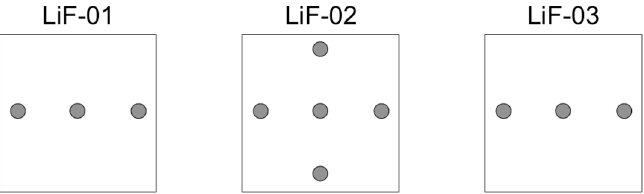
Figure 6. Scheme of the thickness measurement positions of the three thin samples. The nominal thickness was 1.8 µm ( 6 LiF) and 6 µm (aluminum substrate).